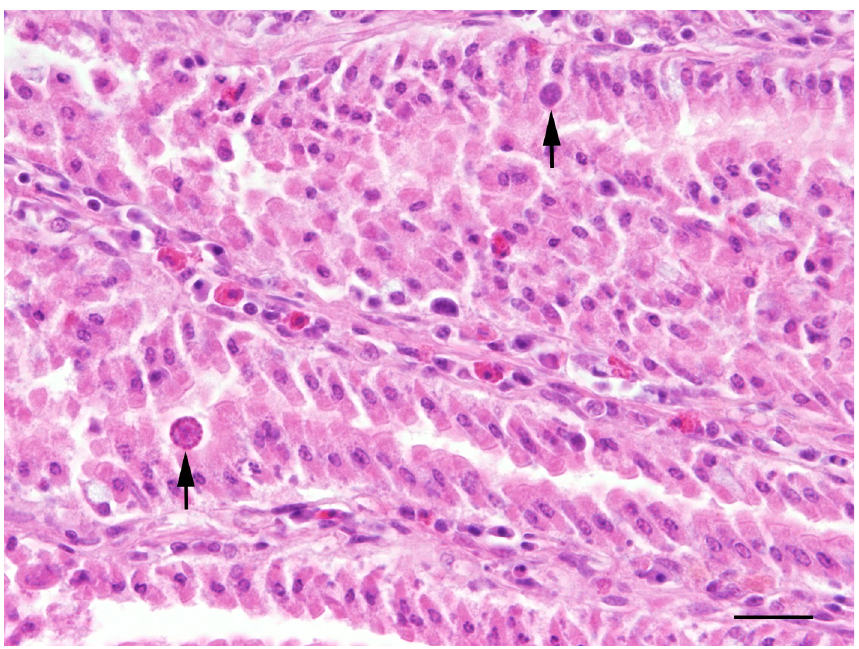
Fig 4. Pheasant chick with mild intestinal coccidiosis characterised by single protozoal microorganisms (arrows) in enterocytes; HE, bar = 60 μ m.